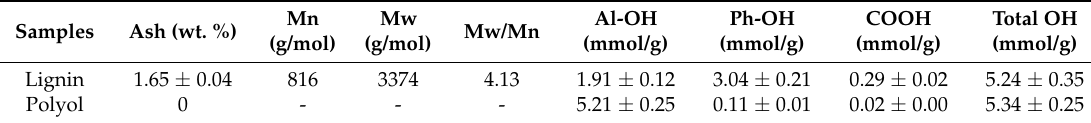
Table 2. Composition of lignin and polyol